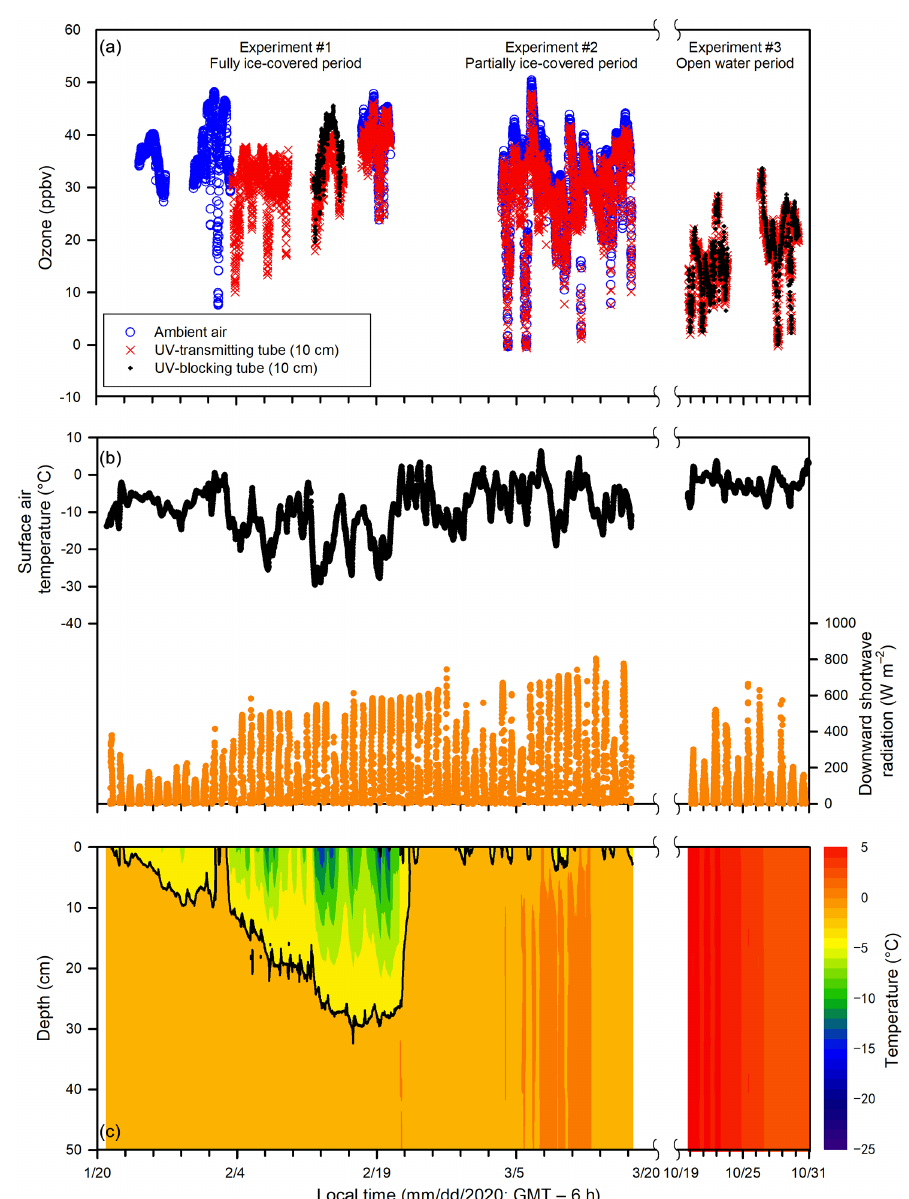
Figure 3. Temporal changes of (a) ozone in the ambient air and the in-tube air inside the UV-transmitting and UV-blocking tubes (10cm above the ice or water surface), (b) surface air temperature, downward shortwave radiation (1.5m above the ice or water surface), and (c) ice and water temperatures in the top 50cm of the pool during Experiments 1, 2, and